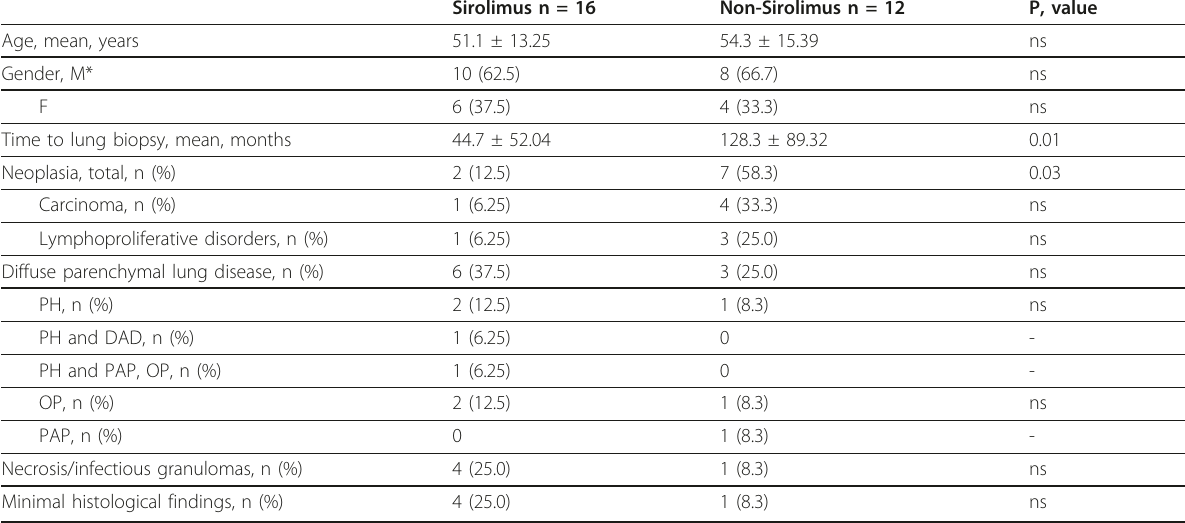
Table 2 Clinicopathological findings in patients on sirolimus versus other immunosuppressive therapy Sirolimus n = 16 Non-Sirolimus n =